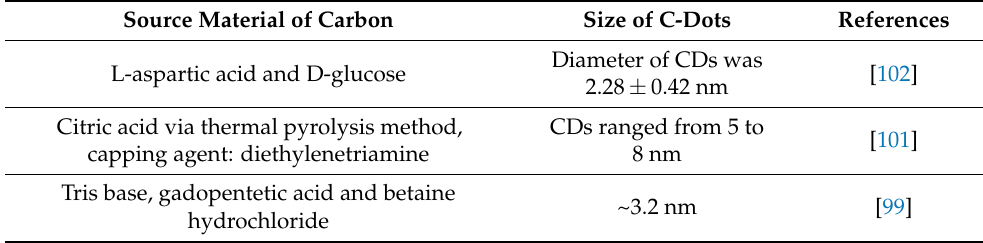
Table 7. Pyrolysis-based methods for synthesis of